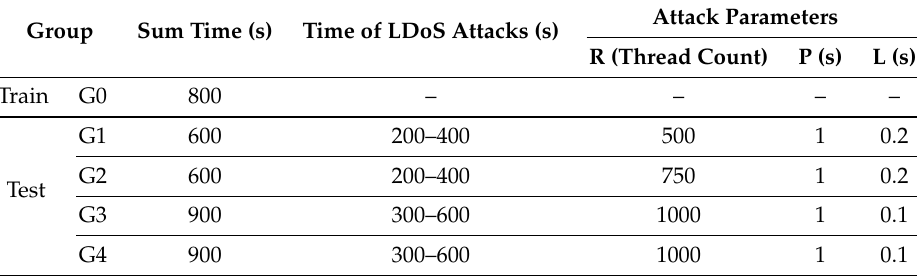
Table 2. Experimental parameters of